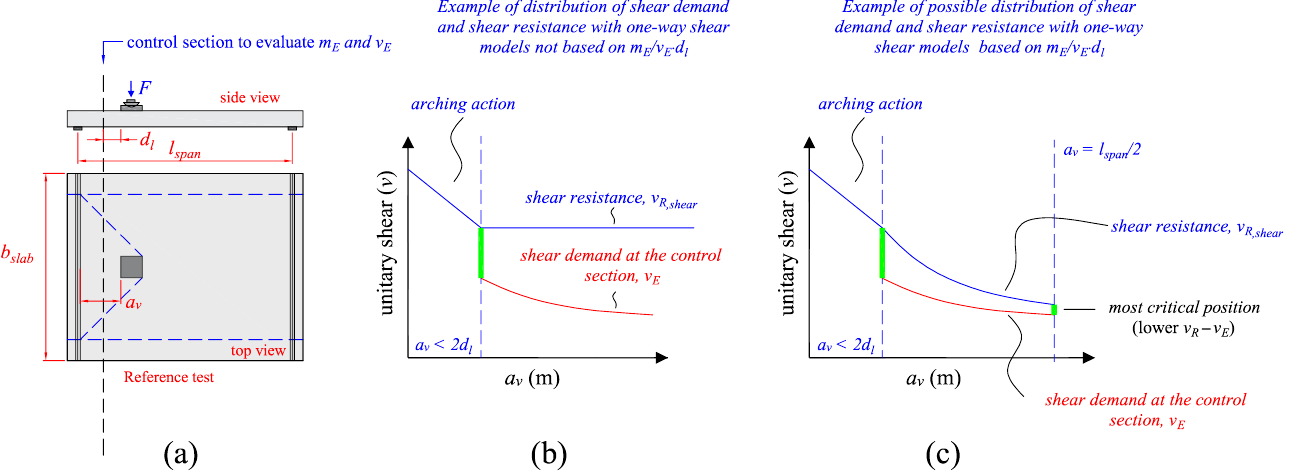
Figure 2. ( a ) Sketch of the test S35B1- 1 from Reiβen [14] and position of the control section on which the acting bending moments and shear demand are evaluated with fib Model Code 2010 [21]; ( b ) example of possible distribution in shear demand v E and shear resistance v R using one-way shear models that do not consider the influence of the ratio m E / v E ∙ d l in the unitary shear capacity (note that the most critical position for one-way shear will always be close to the support in this approach); ( c ) example of possible distribution in shear demand v E and shear resistance v R at the control section with the models that consider the lower shear resistance increasing the ratio m E / v E d l .